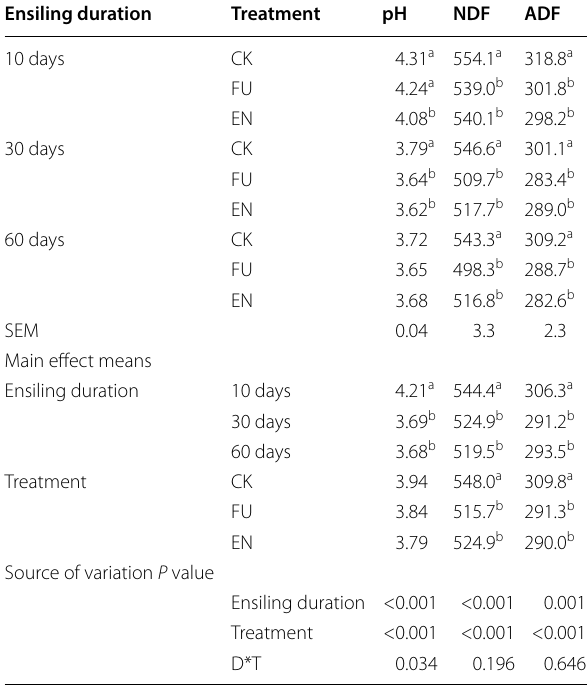
Table 2 Effects of different additive treatments and ensiling durations on the pH value, NDF and ADF contents (g kg − 1 DM) of whole crop maize silage